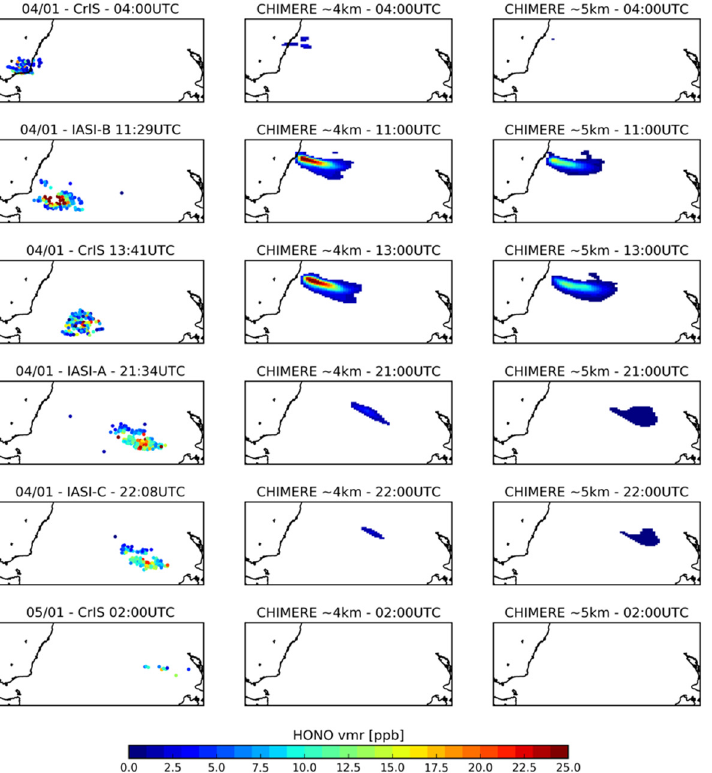
Figure 7. Observed and simulated (~4 and ~5 km) HONO vmrs within the plume around the detection times.